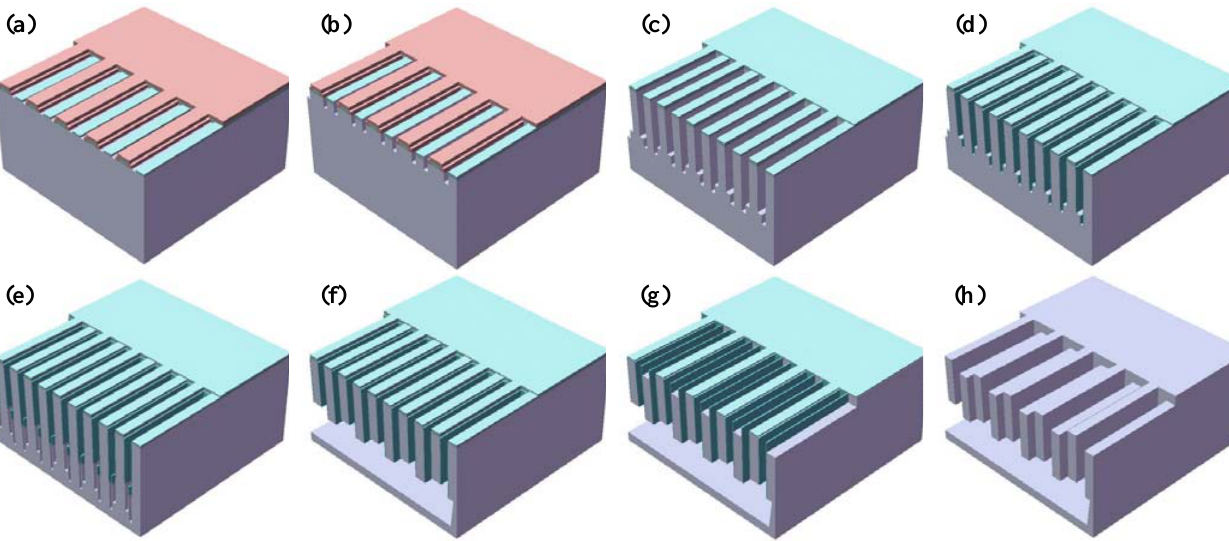
Figure 10. (a) 2nd photolighography & TEOS etch. (b) 1st DRIE. (c) 2nd DRIE. (d) Thermal oxidation & bottom etch. (e) 3rd DRIE. (f) Anisotropic wet etching.